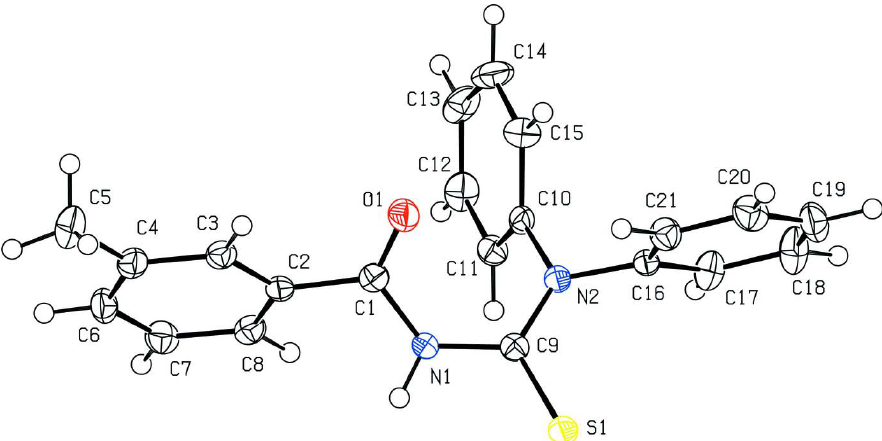
The molecular structure of (I). Displacement ellipsoids are drawn at the 50% probability level.